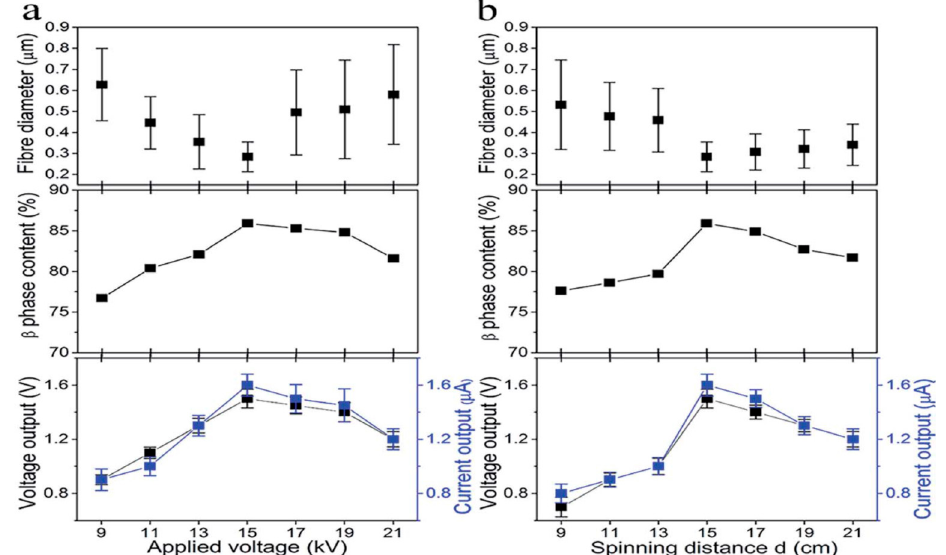
Figure 13. Effects of ( a ) applied voltage and ( b ) spinning distance on the fiber diameters, β -phase contents and electrical outputs of PVDF nanofiber mats (PVDF concentration 20%; nanofiber mat thickness 100 µm). Reproduced with permission from [129], published by Royal Society of Chemistry, 2015.